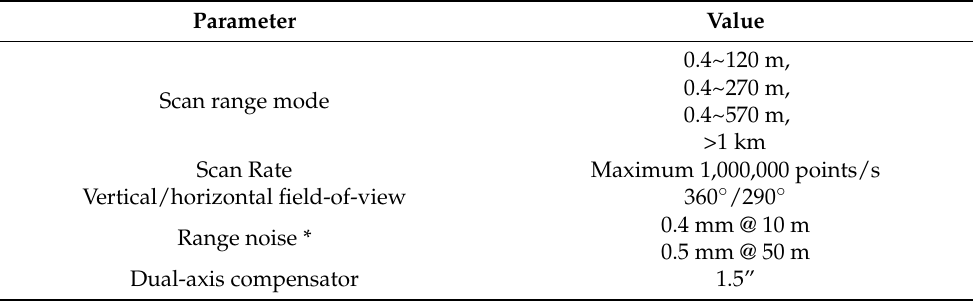
Figure 5. Photos showing Sujiaba Bridge. ( a ) UAV image of Sujiaba Bridge; ( b ) the schematic diagram of scan station in Sujiaba Bridge and the background is from Google Maps. The scan station 1 is 48 m away from the bridge and station 2 is 19 m away from the bridge. Table 1. Parameter of Leica P50 3D laser scanner [46].